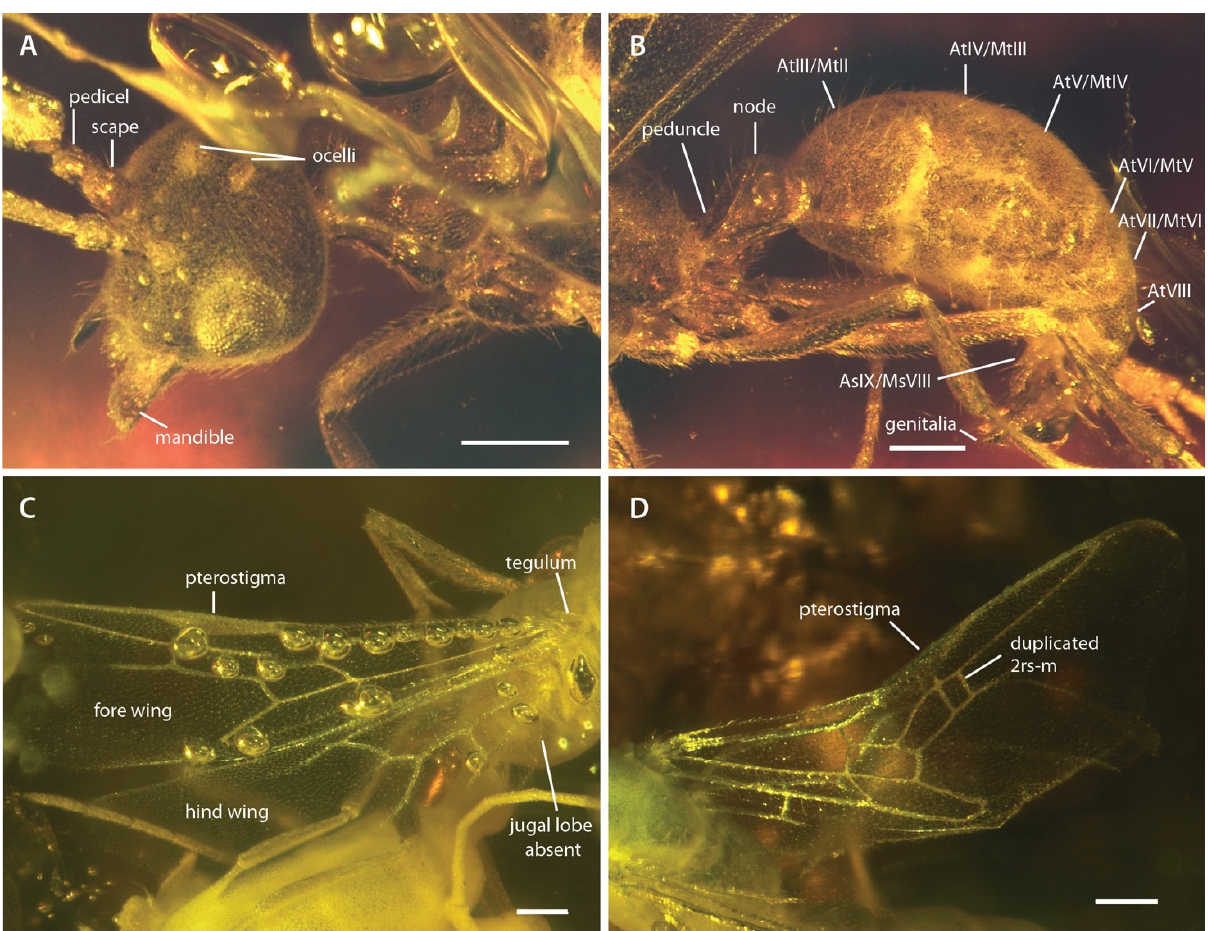
Figure 2. Photographs of † Desyopone hereon gen. et sp. nov., MAIG 6016. ( A , B ) holotype, anterodorsolateral views of head and metasoma; ( C ) paratype 1, wing view; ( D ) paratype 4, wing view. AtIII/MtII: abdominal tergite III/metasomal tergite II; AsIX/MsVIII: abdominal sternite IX/metasomal sternite VIII. Note that the specimen figured in D has a duplicated crossvein 2rs-m on right fore wing. Scale bars: 0.25 mm.